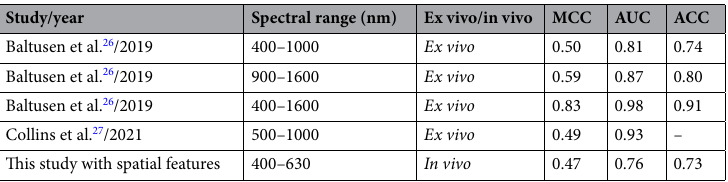
Table 3. Comparison with the results from other groups.